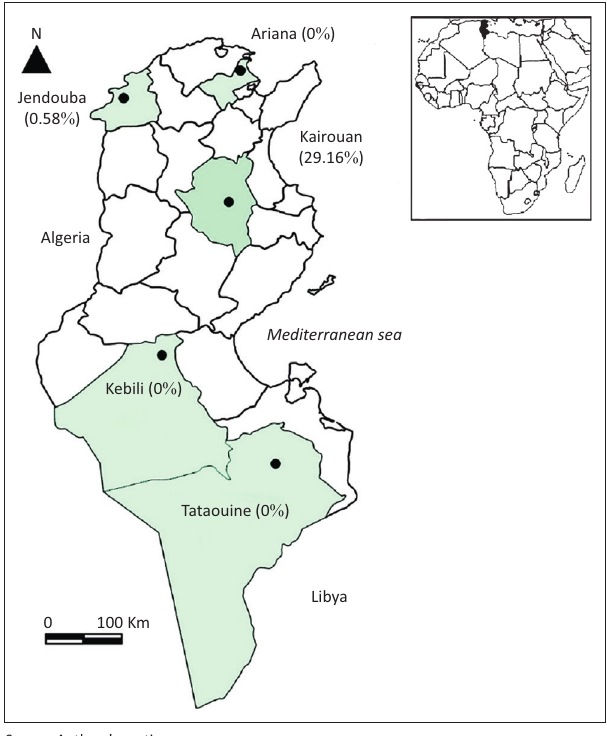
FIGURE 1: Sheep Mycoplasma ovis molecular prevalence in five Tunisian localities. Prevalence, as percentage, indicated between